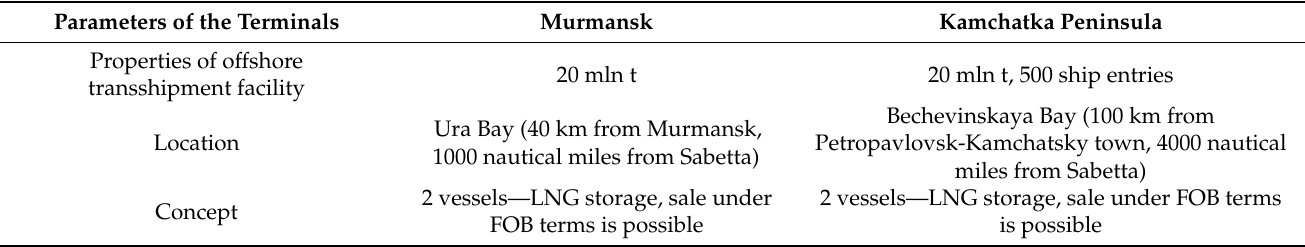
Table 1. Parameters of the transshipment